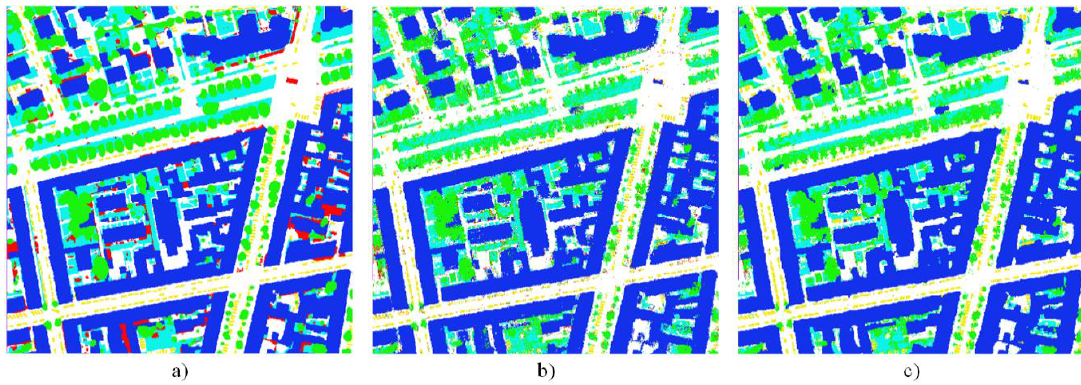
Figure 9. Spatial Operation on patch No. 5-11 a) Ground truth b) Classified image c) Result of refinement by spatial